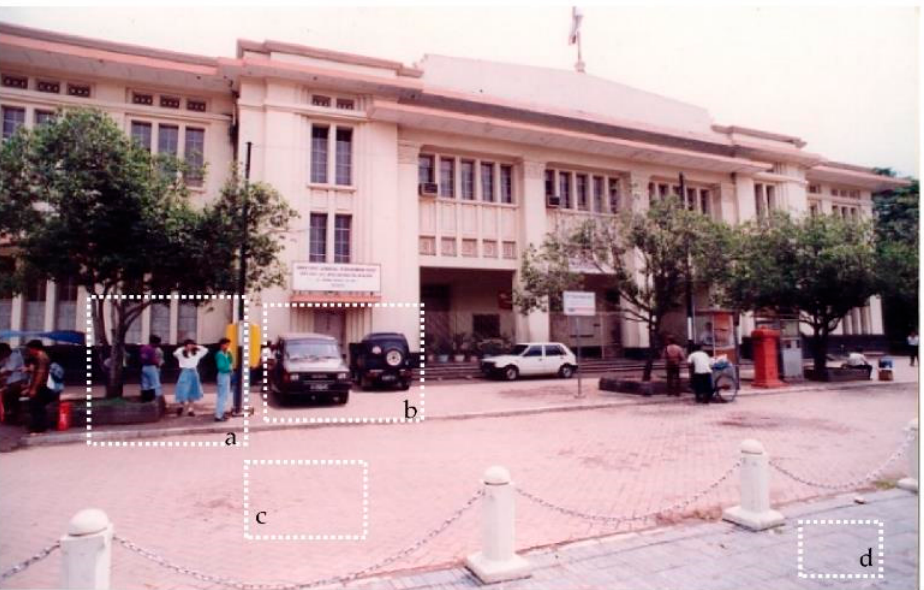
Figure 15. The situation of Central Post Office buildings at Fatahillah Square in 1980s. Identified sound sources: ( a ) humans ( b ) vehicles ( c ) road line with bricks ( d ) the square with natural stone. Source: Private Collection of Attahiyyat.